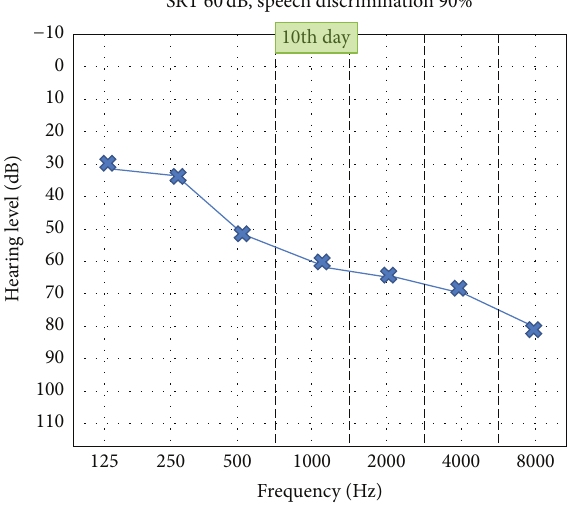
Figure 2: Audiogram after 10 sessions of hyperbaric oxygen